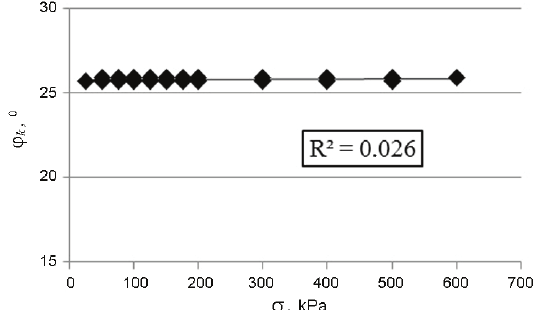
Fig. 15. The angle of internal friction versus vertical stress (results of 21 tests)